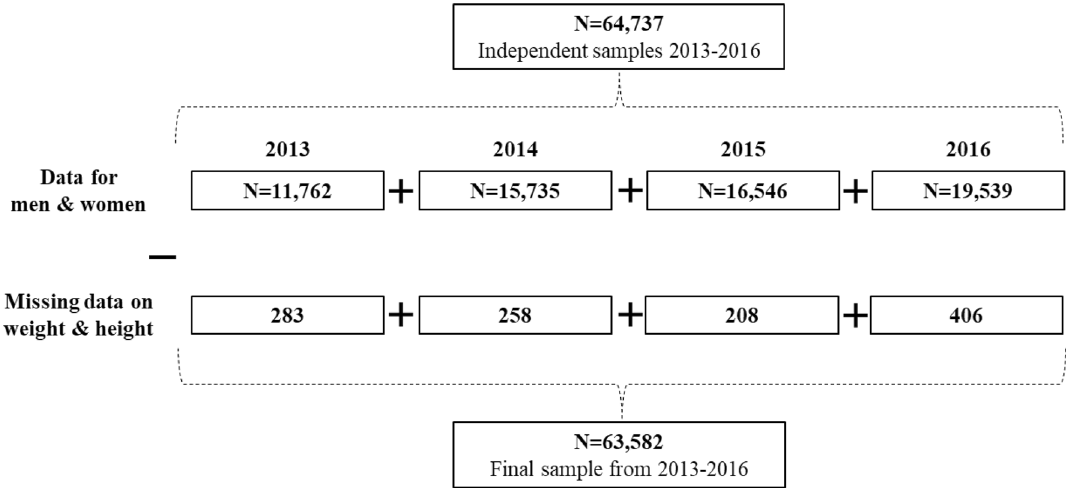
Figure 1. Flowchart for the selection of